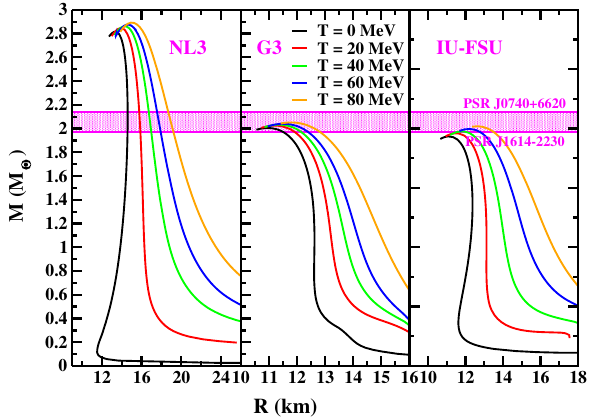
Fig. 10 M-R profile of proto-neutron star at different temperatures for NL3 (left panel), G3 (middle) and IUFSU (right panel) parameter sets respectively